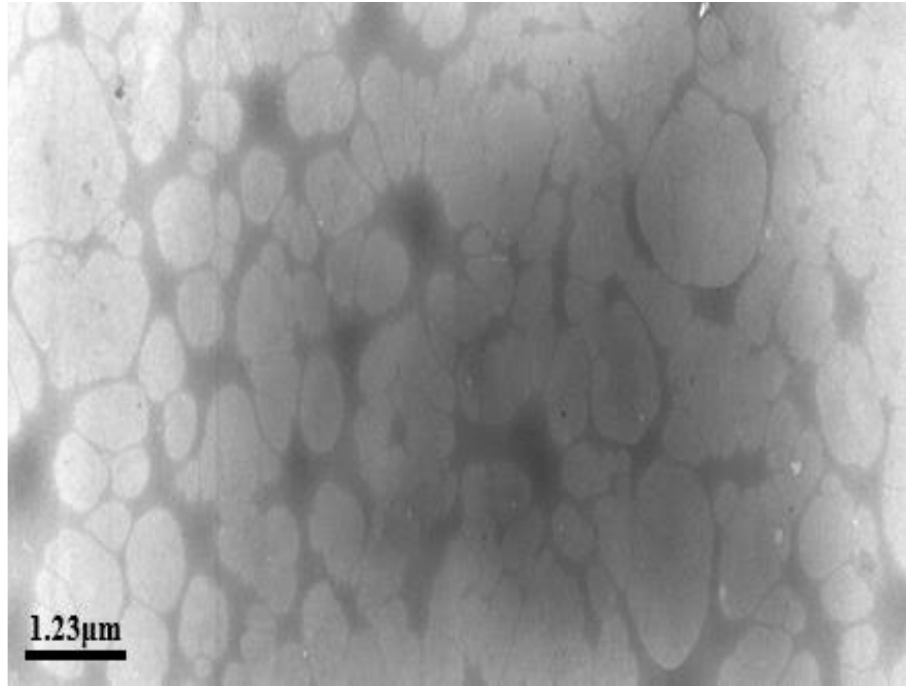
Figure 10. Micro-structure of the drag reducer after being subjected to low rate of flow shear. The micro-structure of sample C experiencing high shear rate flow is shown in Figure 11, which is quite different from that of samples A and B.